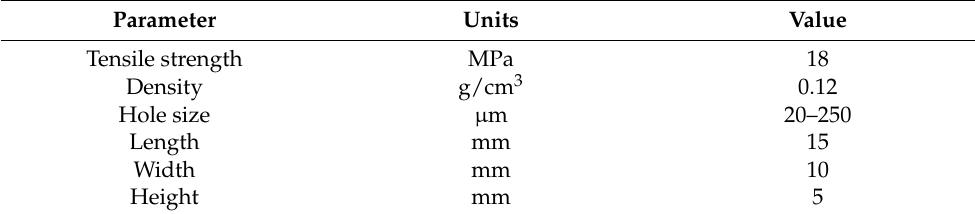
Figure 1. ( a ) Fabrication process of the PGSPS. ( b , c ) Photographs of folded and twisted PGSPS. ( d ) Photograph of PGSPS. Table 1. The principal characteristics of the SBR foam used in PGSPS.